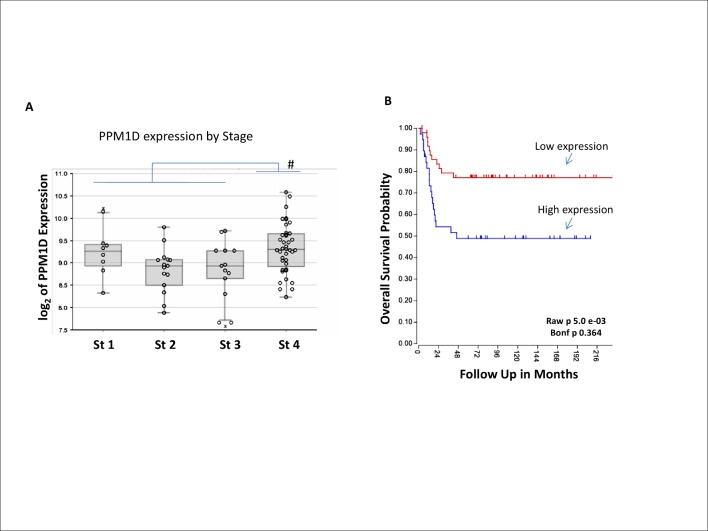
WIP1 expression correlates with neuroblastoma disease stage.
A, Analysis of a large patient cohort (88 patients) with annotated clinical data and long term follow up (Versteeg-88-Mas5.0) demonstrates higher PPM1D levels in stage 4 metastatic subgroup (# = p < 0.01, # # = p < 0.005, by Student T-test). B, Long-term survival was also significantly (Kaplan-Meier analysis p = 0.005) different for high (n = 50) versus low (n = 38) expression of PPM1D.